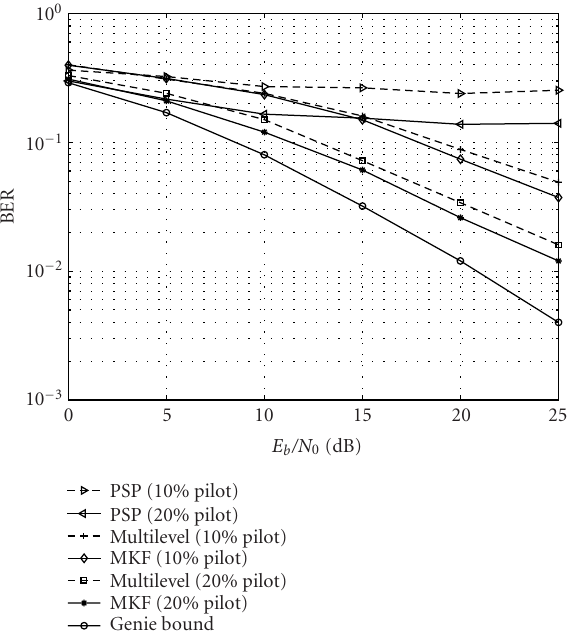
Figure 2: The BER performance of the PSP, MKF, and multilevel MKF for pilot-aided 16-QAM over flat-fading